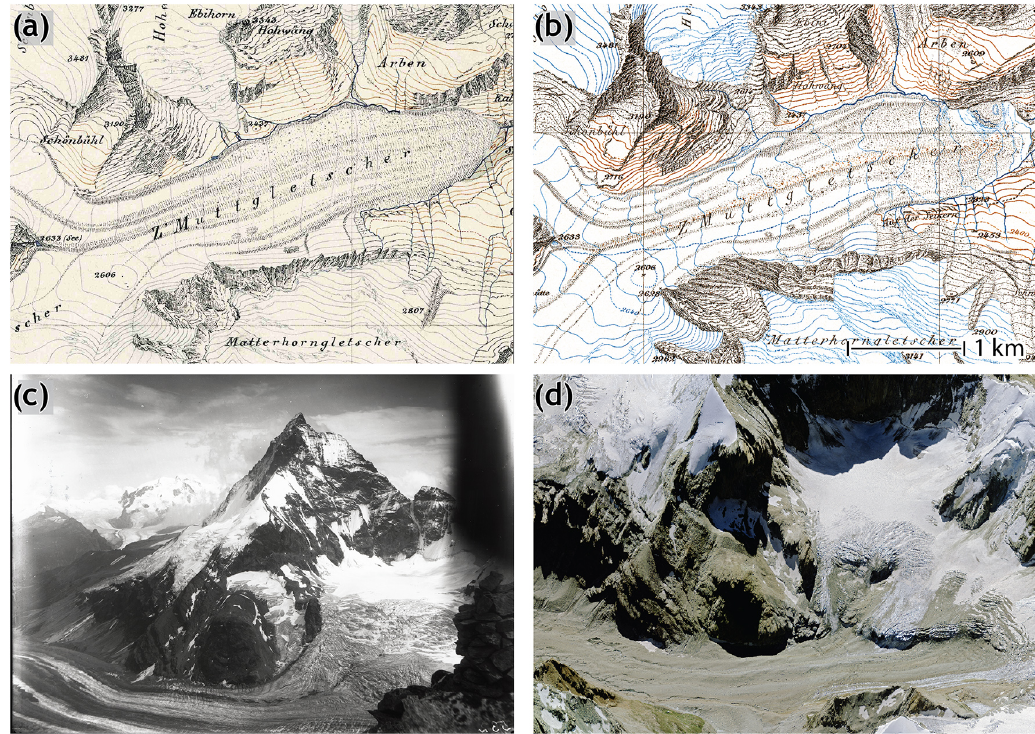
Figure 2. Example of mapped debris cover on (a) Dufour map, 1859 (© SwissTopo), and (b) Siegfried map, 1879 (© SwissTopo). (c) Parts of the tongue in 1894 towards the south-west (Reid, 1894; National Snow and Ice Data Center, 2002, updated 2015). (d) Similar extent as in (c) in 2013 (Swisstopo, 2010). Panels (c) and (d) show the main tongue and